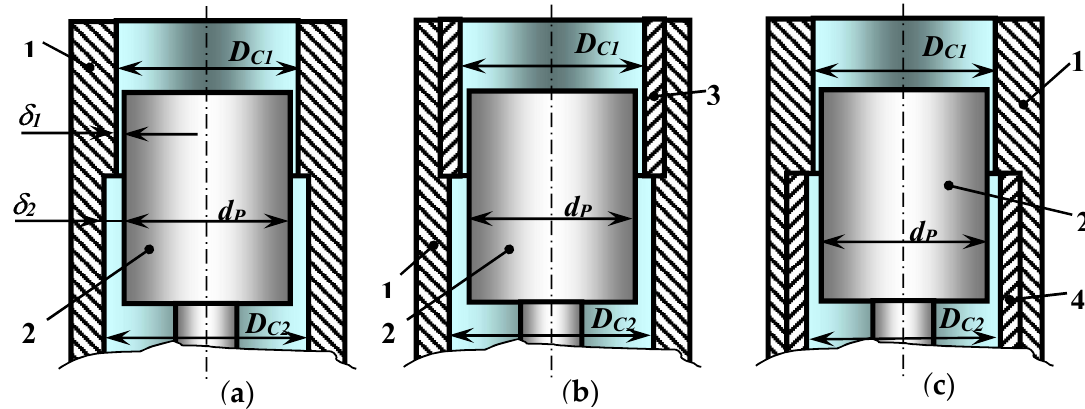
Figure 3. Possible options for the step clearance in the cylinder-piston group of the machine under study: ( a ) the upper and lower clearances are constant; ( b ) upper clearance is variable, lower one is constant; ( c ) the upper clearance is constant, the lower one is variable. ( 1 ) Cylinder. ( 2 ) Piston. ( 3,4 ) Replaceable bushings.